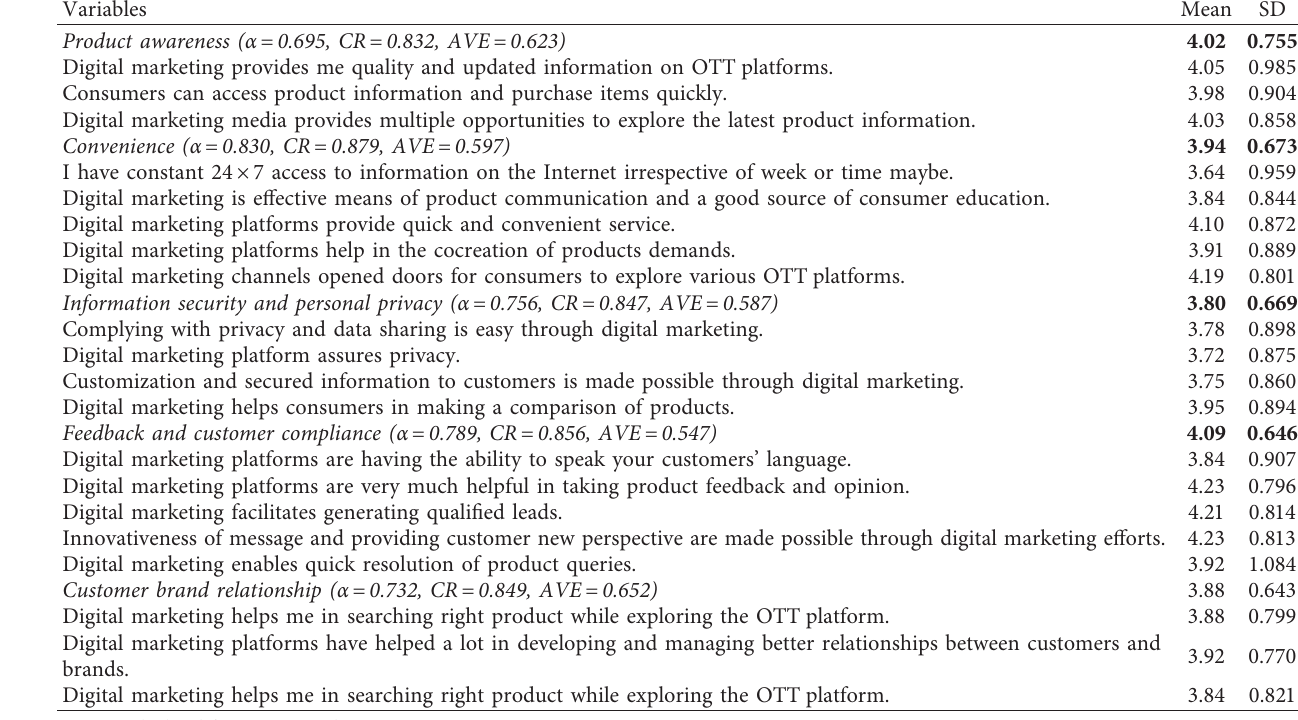
Table 4: Factors of DMM influencing customers to subscribe to OTT platforms: a descriptive statistics.